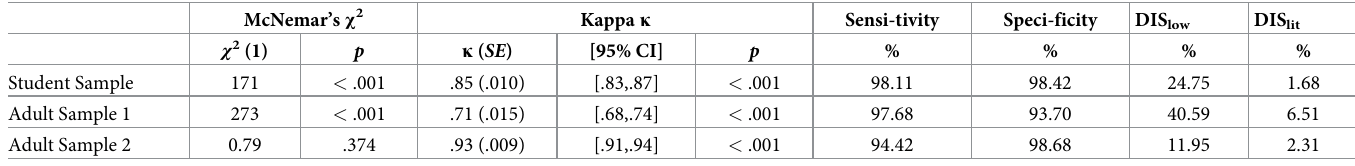
Table 5. Measures for agreement between the bookmark procedure (BM) and constrained Mixture Rasch Model (cMRM) in different samples.